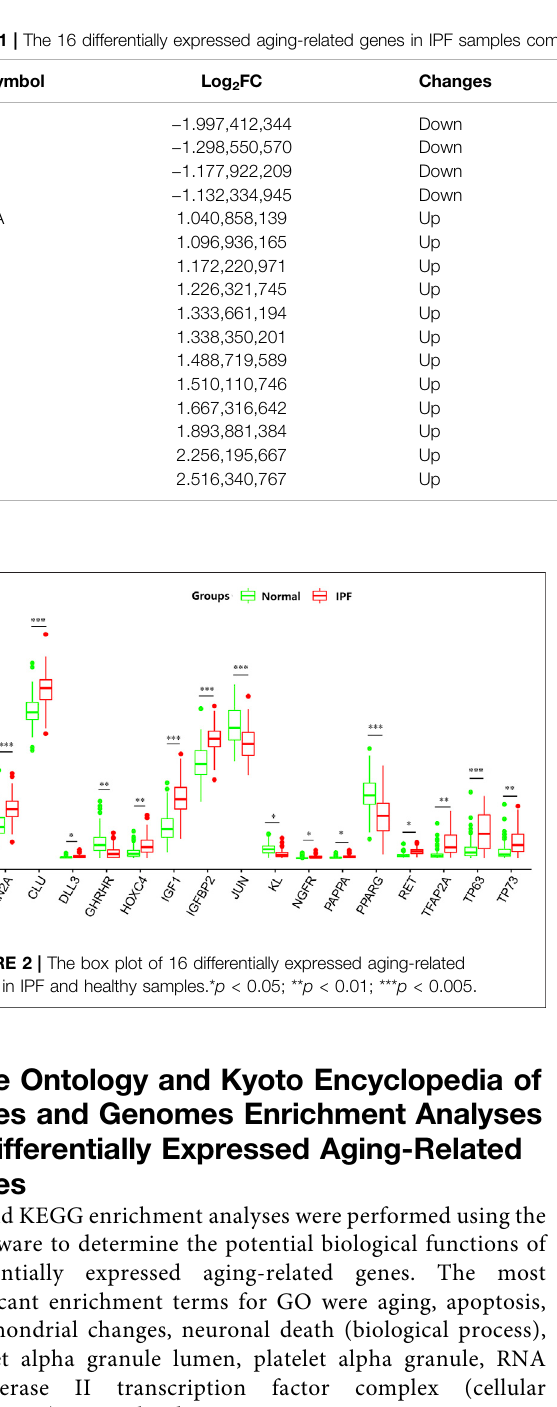
Frontiers in Genetics |